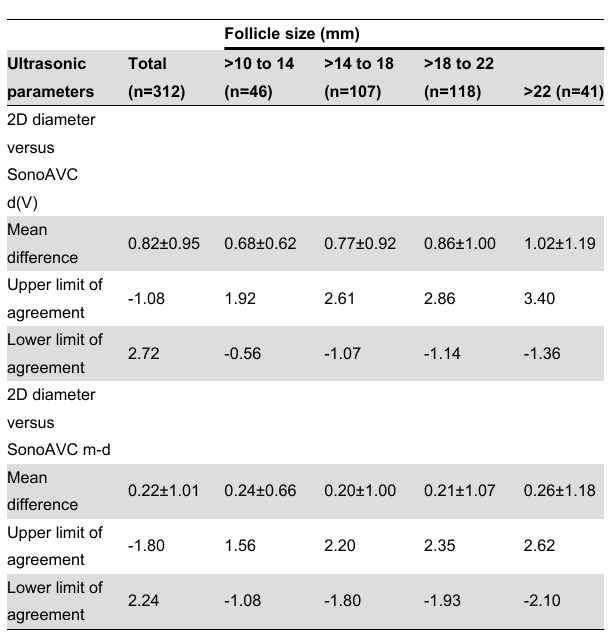
Table 3. Bland-Altman plot analysis of 2D measurement and SonoAVC in various follicle